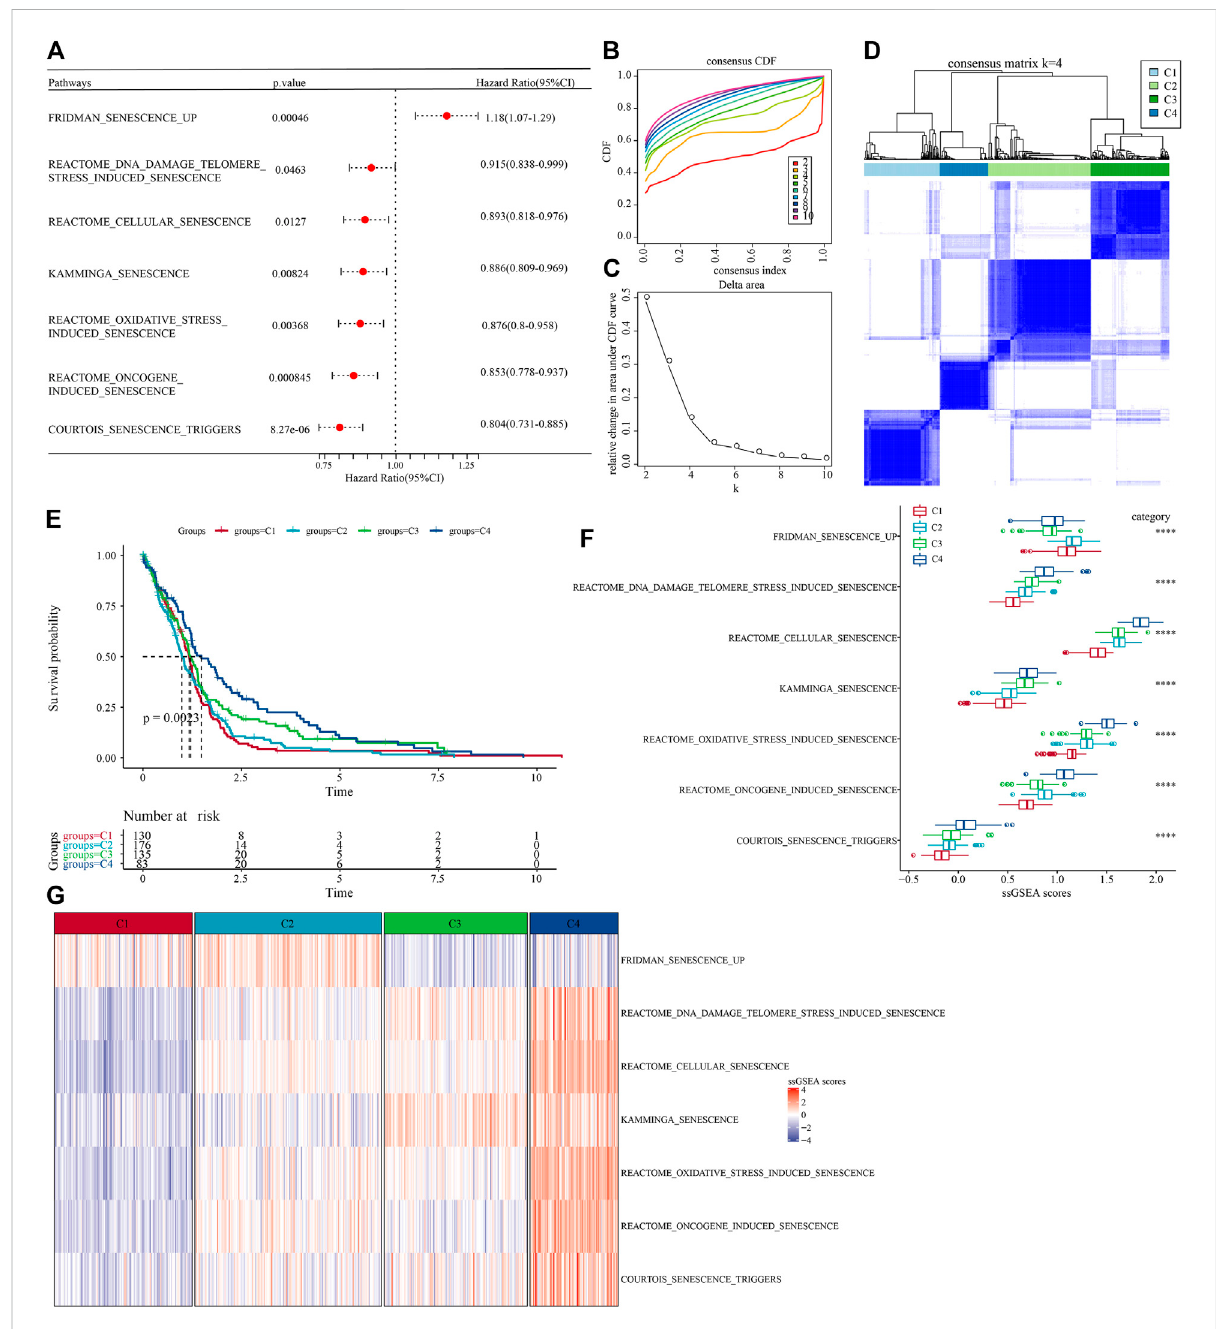
FIGURE 1 Molecular subtype with cell senescence-related pathwaysscore in TCGA-GBMcohort. (A) Forest map of cell senescence associated pathways withsigni fi cantprognosis; (B) TCGA-GBMcohortqueuesampleCDFcurve; (C) .TCGA-GBMcohortsampleCDFDeltaareacurve,Deltaareacurveof consensusclustering,indicatingtherelativechangeinareaundertheCDFcurveforeachcategorynumberkcomparedwithk – 1.Thehorizontalaxis represents the category number k and the vertical axis represents the relative change in area under CDF curve; (D) The heat map of sample clustering when consensus k = 4; (E) relationship KM curve of prognosis of four subtypes; (F) Differences of “ ssgsea scores ” of cell aging-related pathways with signi fi cant prognosis among different subtypes of TCGA-GBM cohort; (G) “ ssGSEA scores ” thermograms of cell aging-related pathways with signi fi cant prognosis in different subtypes of TCGA-GBM